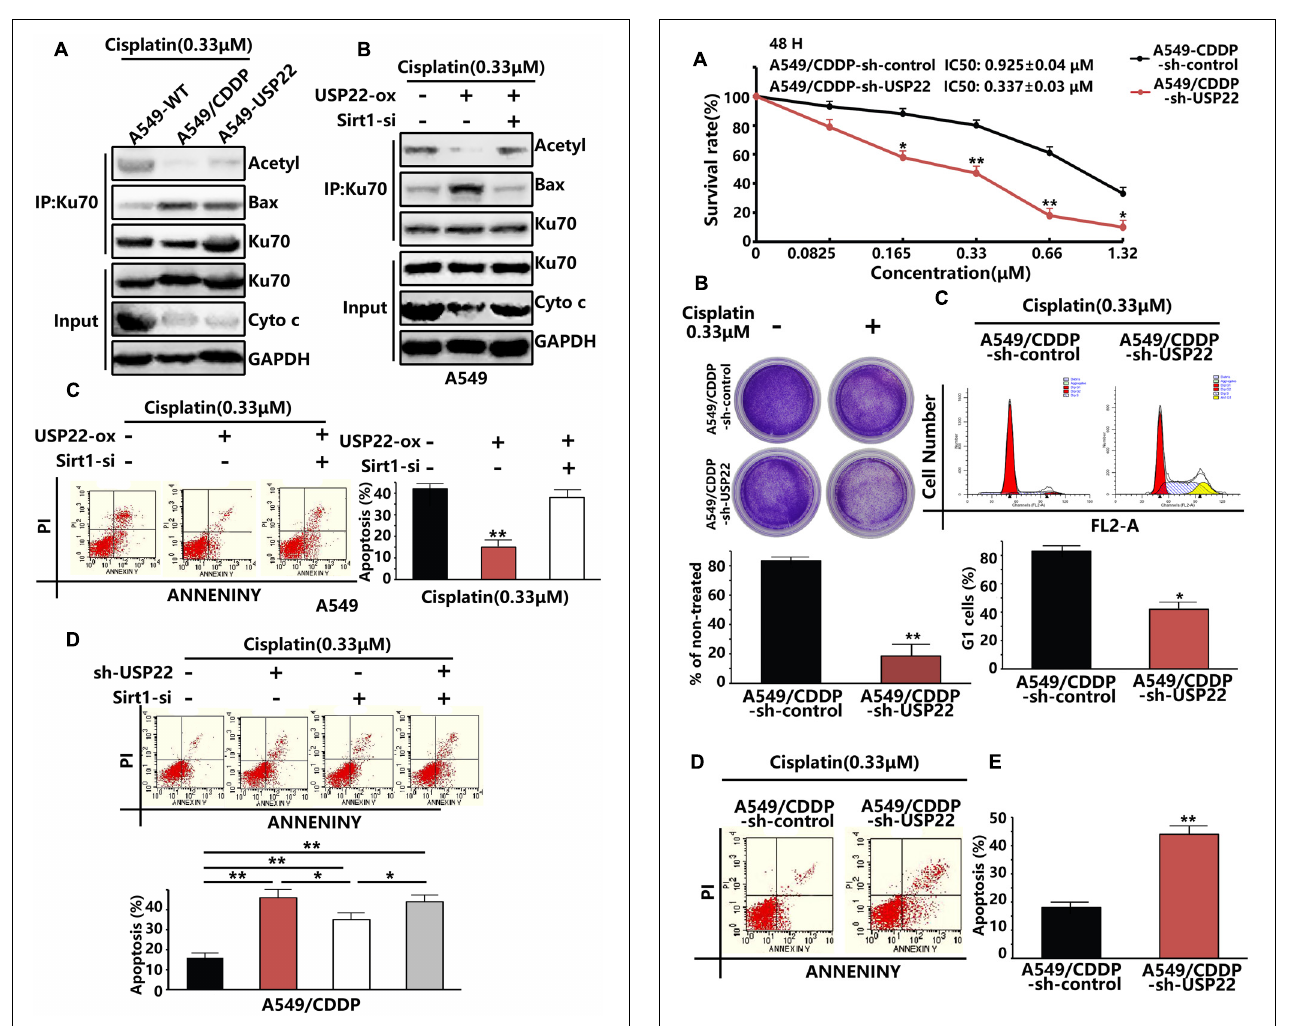
FIGURE 4 | USP22 decreases the acetylation of Ku70 by stabilizing Sirt1, thus inhibiting Bax-mediated apoptosis and inducing cisplatin resistance. (A) Acetylated Ku70 and the Bax binding to Ku70 were detected by IP and cytochrome C was detected by western blot analysis in A549-WT, A549/CDDP and A549-USP22 cells, after 0.33 µ M cisplatin treatment for 48 h. (B) Acetylated Ku70 and the Bax binding to Ku70 were detected by IP and cytochrome C was detected by western blot analysis in A549 cells which were transfected by vector, USP22, USP22+Sirt1-siRNA, after 0.33 µ M cisplatin treatment for 48 h. (C) Apoptosis in A549 cells which were transfected by vector, USP22, USP22+Sirt1-siRNA was demonstrated by flow cytometric analysis, after 0.33 µ M cisplatin treatment for 48 h. (D) Apoptosis in A549 cells which were transfected by si-control, sh-USP22, Sirt1-si and sh-USP22+Sirt1-si, after 0.33 µ M cisplatin treatment for 48 h. Every experiment was conducted at least three times, and the average is shown (mean ± SD). ∗ P < 0.05, ∗∗ P < 0.01, significant.